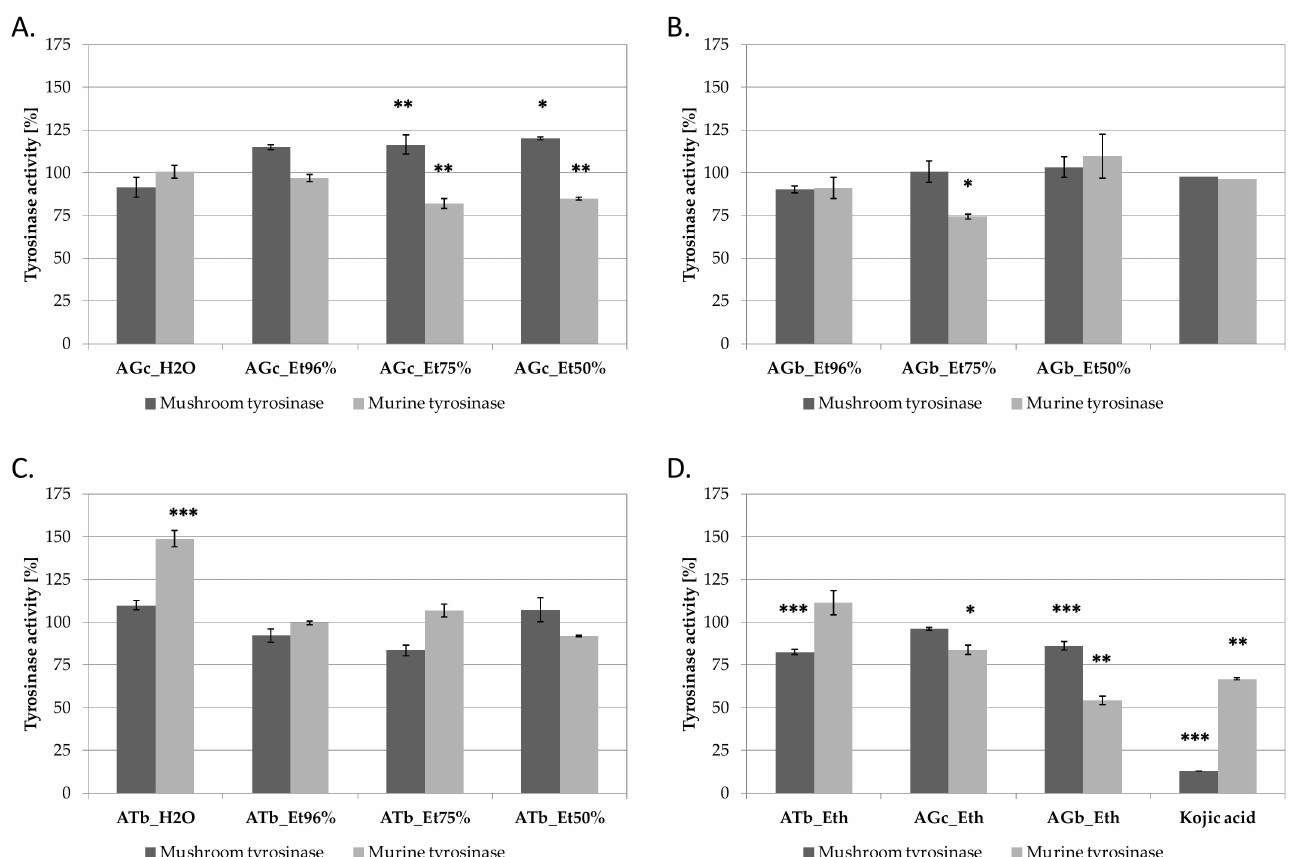
Figure 2. Mushroom and murine tyrosinase inhibitory activity of A. galanthus chives ( A ) and bulbs ( B ) (AGc and AGb, respectively), A. turkestanicum bulbs (ATb) ( C ) and diethyl ether extracts from AGc, AGb and ATb ( D ) extracts at 100 µ g/mL in comparison with 100 g/mL kojic acid; values on graphs represent mean ± SD ( n = 3 ), *** p < 0.001, ** p < 0.01, * p <